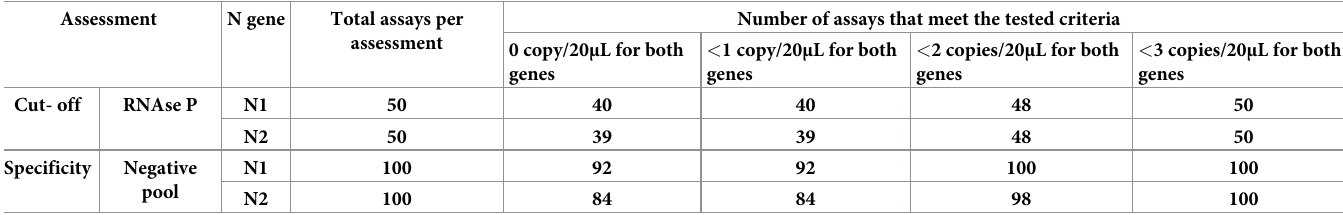
Table 1. Summary of cut off- and specificity